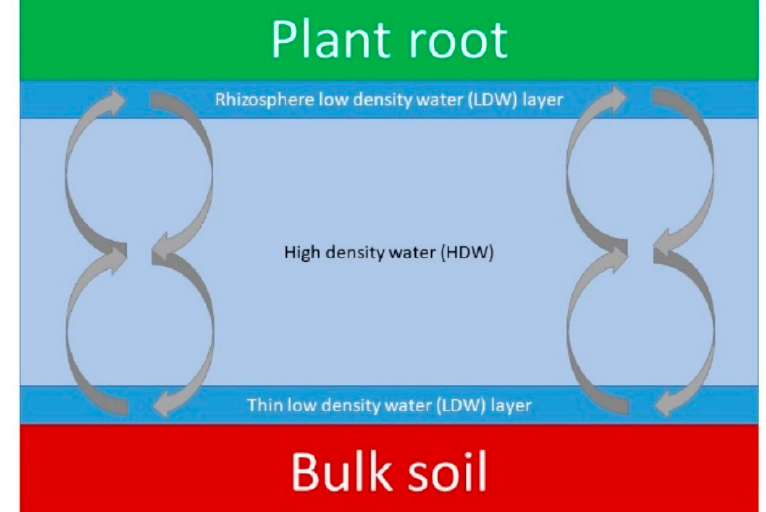
Figure 18. Mechanism for nutrient fluxes. Due to the LDW ⇄ HDW equilibrium occurring on bulk soil surface, the nutrients leave soil surface to enter the soil solution. Afterwards, due to a similar LDW ⇄ HDW equilibrium occurring on the root surface, they leave the soil solution to enter the rhizosphere solution from where they can be taken up by plant roots. The grey arrows represent the LDW ⇄ HDW equilibria.